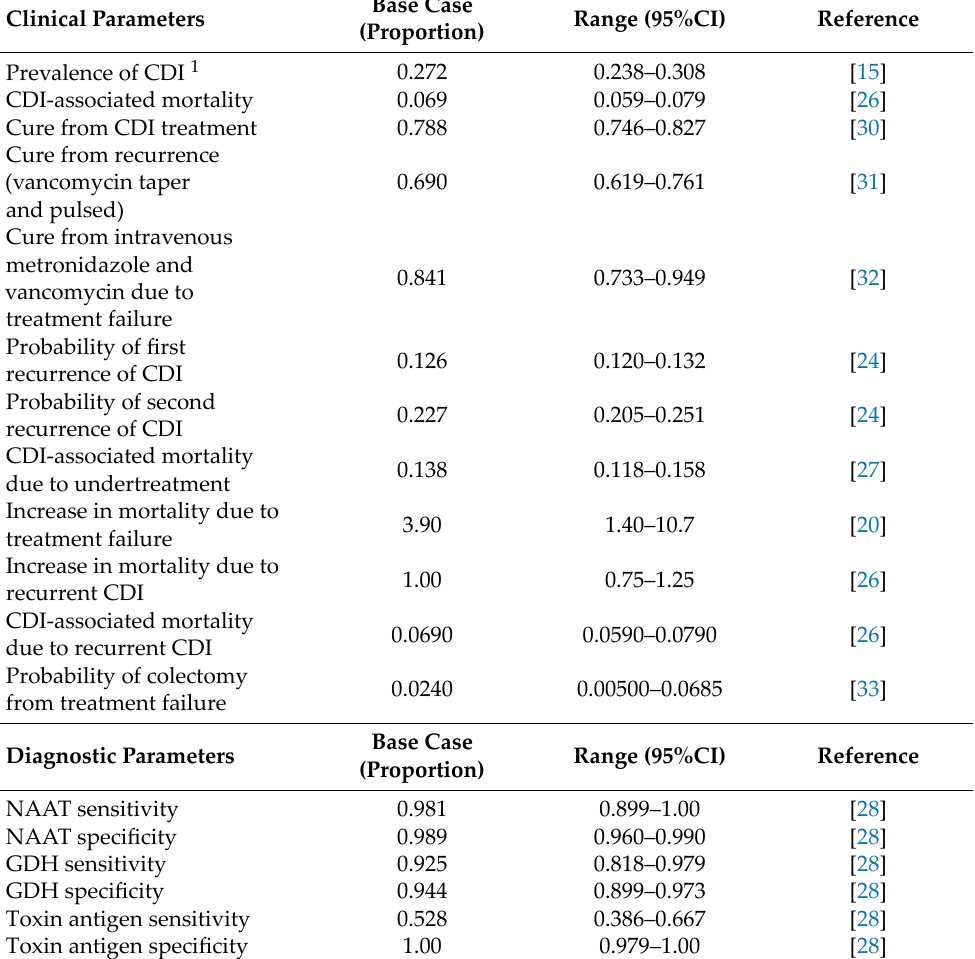
Table 1. Clinical, diagnostic, and economic parameters of the budget impact analysis. Clinical